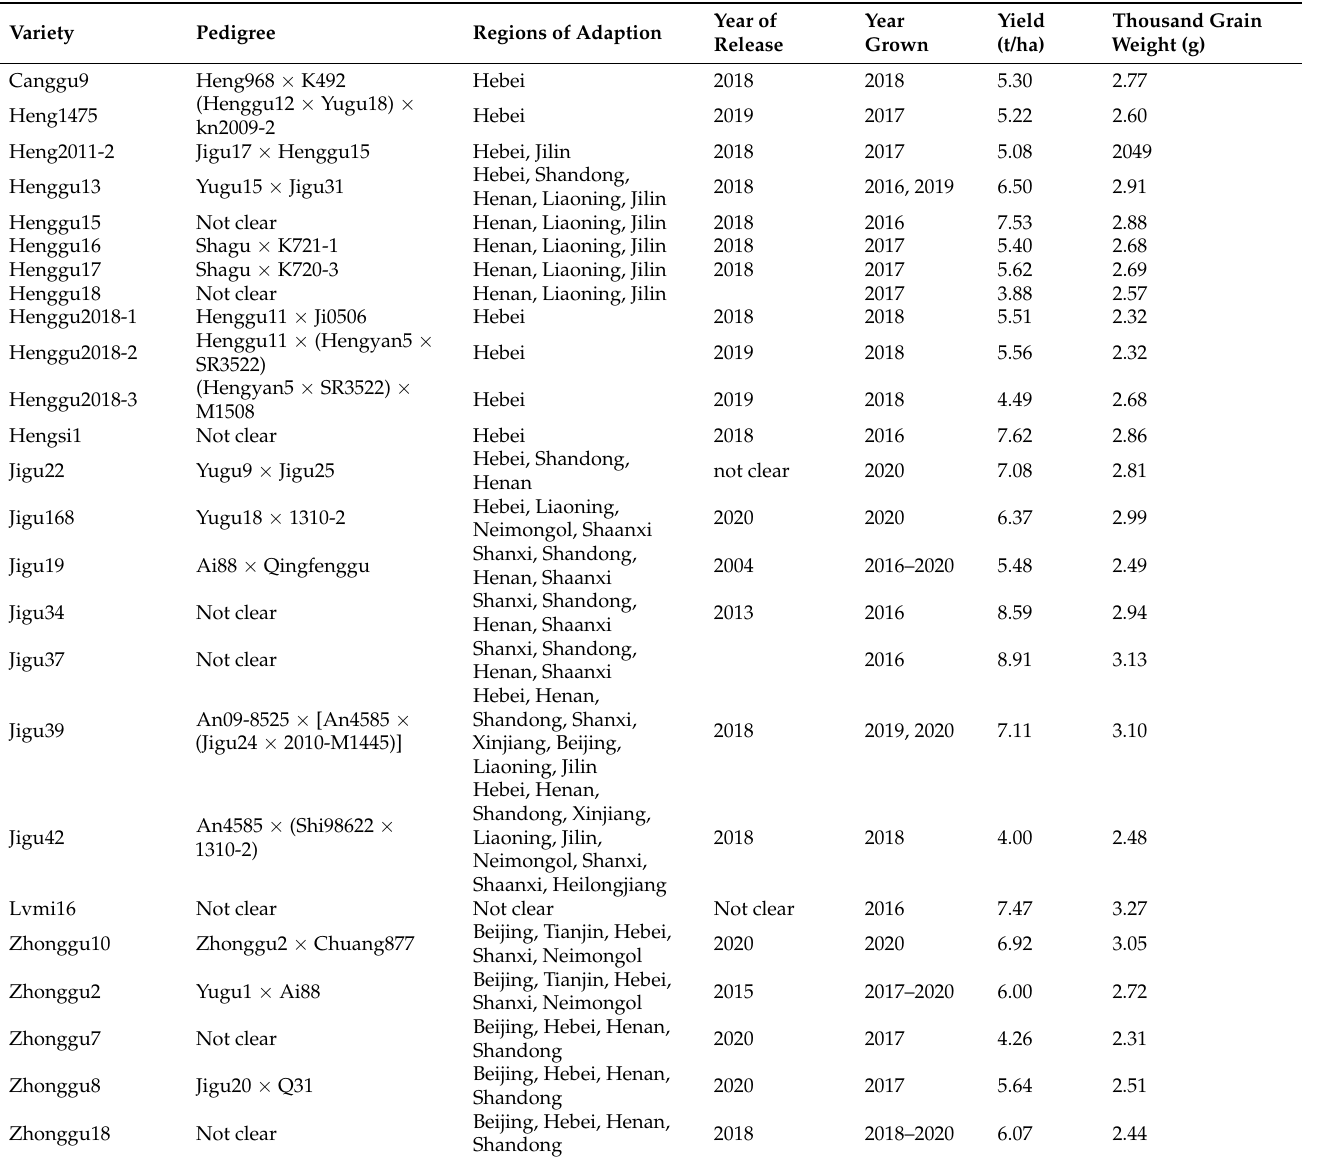
Table A1. The information of 25 varieties.